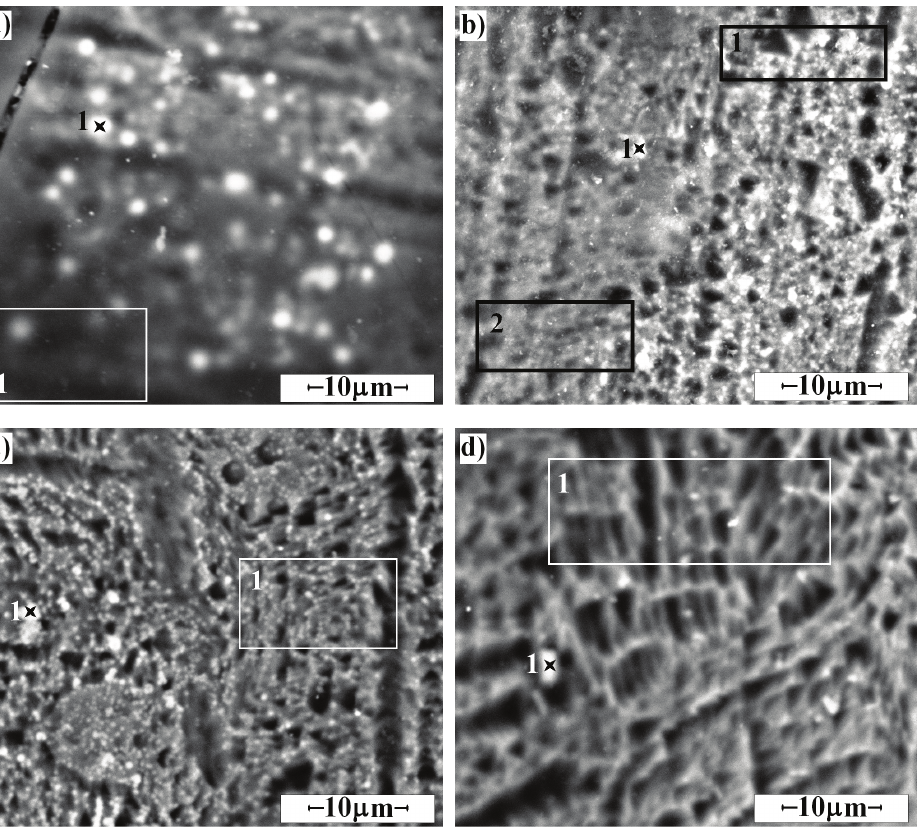
Figure 2: Microphotographs (SEM) of surface of monolithic 0.15% wt. Pt(Cl) catalysts calcined in different conditions. Calcination conditions: a) 4.5 h at 400 o C in the static air, b) 3 h at 500 o C in the static air, c) 3 h at 600 o C in the static air, d) 3.5 h at 500 o C in the